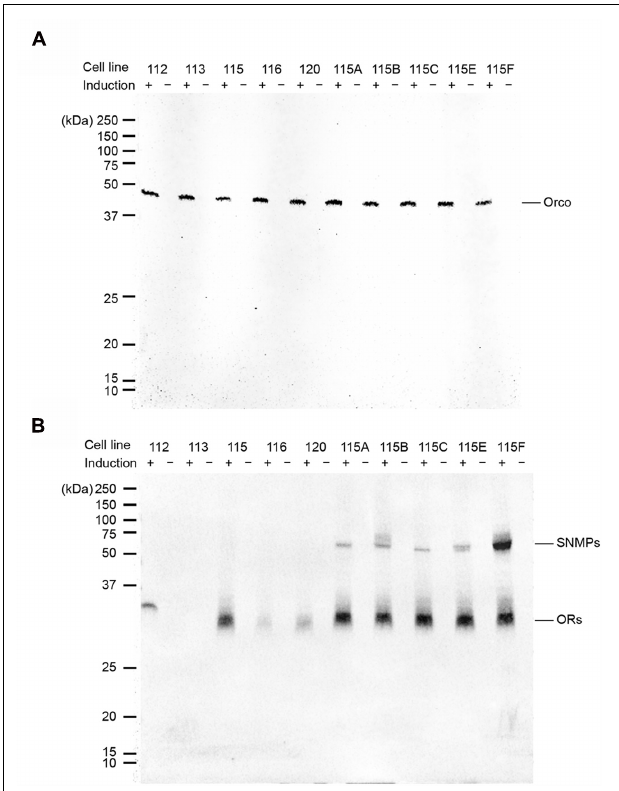
FIGURE 1 | Protein expression of myc-tagged Orco (A) and V5-tagged ORs and SNMPs (B) in cell lines with induced ( + ) gene expression, as indicated by Western blots. No proteins were detected from non-induced cells ( − ). Numbers (112, 113, 115, 116, and 120) refer to the MdesORs, and letters (A, B, C, E and F) to the SNMP1 paralogs. The OR113 protein could not be